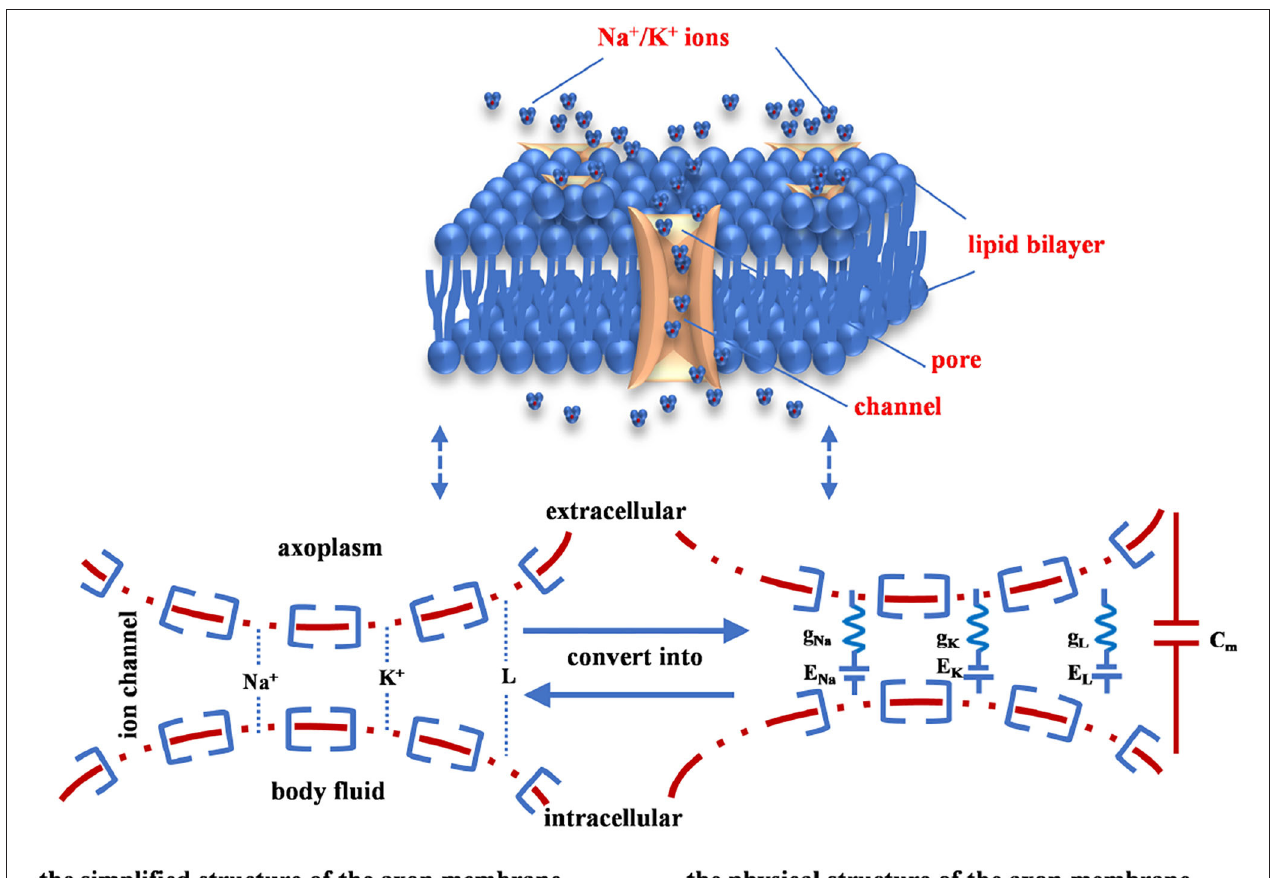
FIGURE 1 | The voltage-gated channel of the axon cell